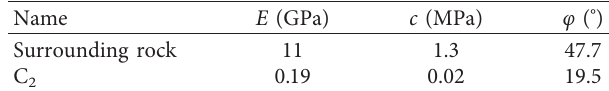
Figure 10: Underground powerhouse model and excavation layer diagram on the left bank of Baihetan: (a) integral model of the left bank underground powerhouse; (b) schematic diagram of excavation layers of the left bank underground powerhouse. Table 2: Mechanical parameters of the surrounding rock and C 2 .